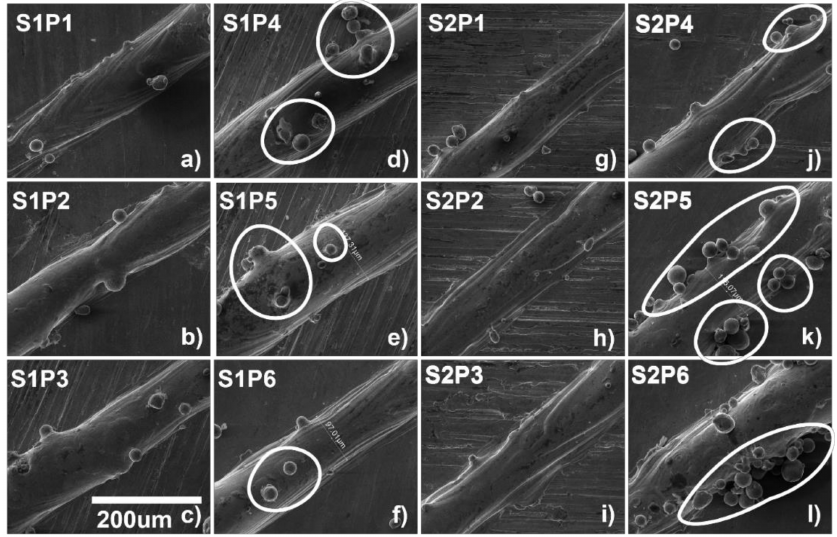
Figure 19. Surface morphology of single tracks for ( a ) P1S1, ( b ) P1S2, ( c ) P1S3, ( d ) P1S4, ( e ) P1S5,